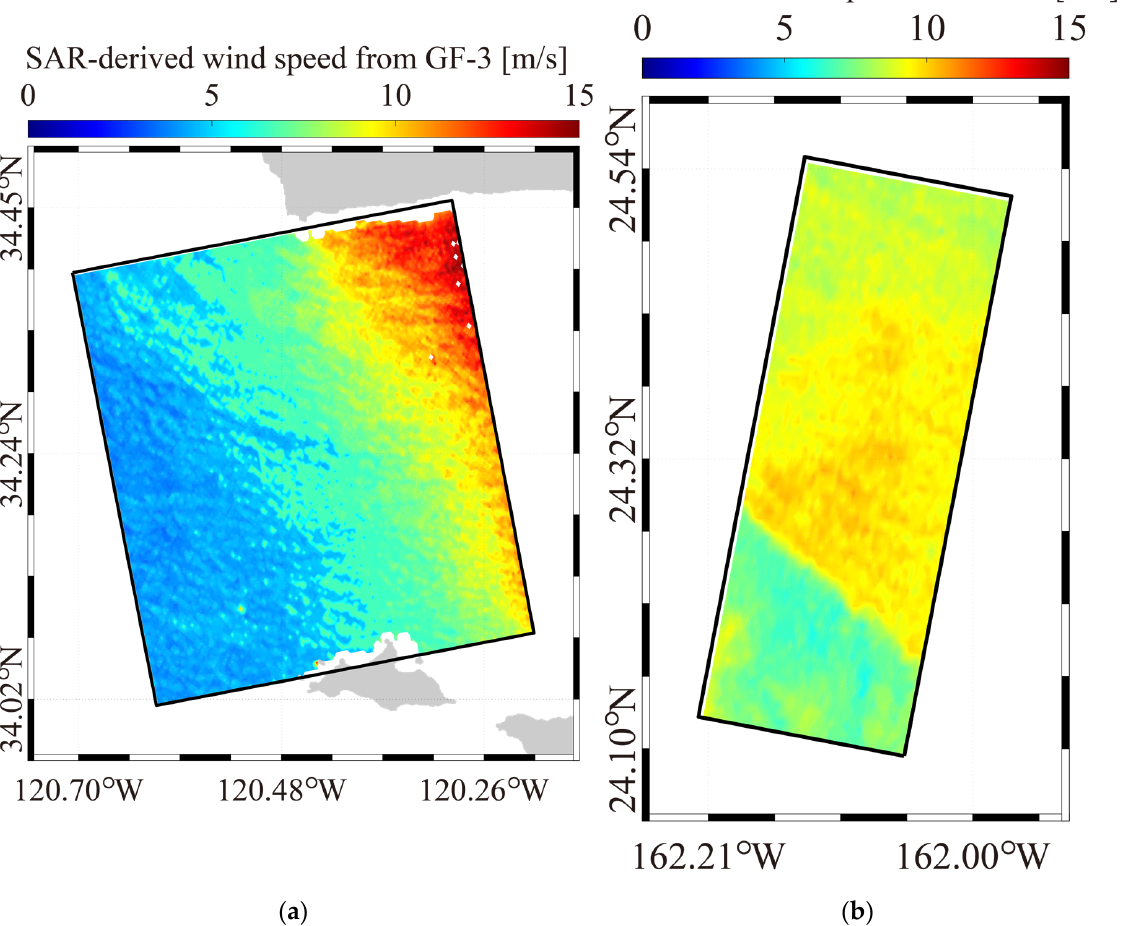
Figure 7. SAR-derived wind maps obtained ( a ) using CSARMOD-GF from the GF-3 SAR image at 1:58 UTC on 5 May 2017, and ( b ) using XMOD-2 from the TS-X image at 16:53 UTC on 3 August 2009.